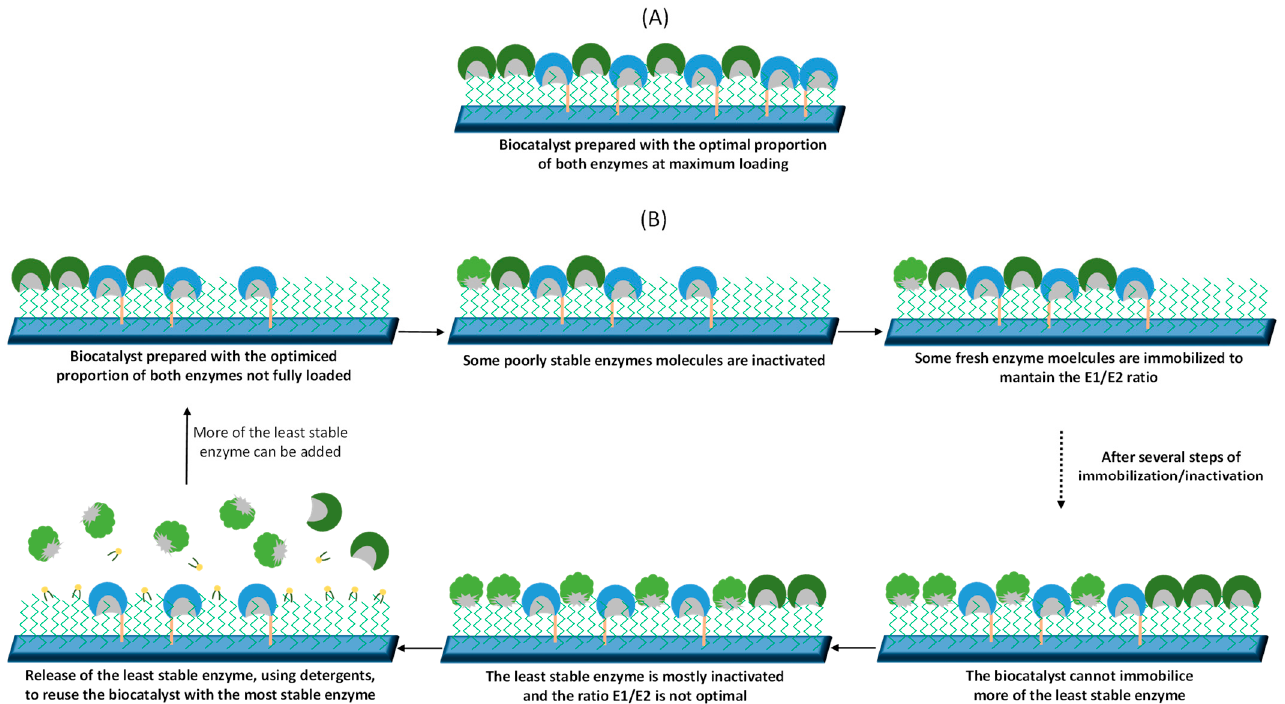
Figure 11. Compatibility of the combi-biocatalysts prepared following Figure 10 with the strategy of using an enzyme under the maximum loading and adding more of the least stable enzyme when required, but with the possibility of reusing the most stable enzyme to prepare more combi-biocatalyst. ( A ) Biocatalyst prepared under the optimal initial conditions at the maximum loading. ( B ) Biocatalyst was prepared considering the inactivation of the least enzyme to keep the optimal E1/E2 rate ratio.